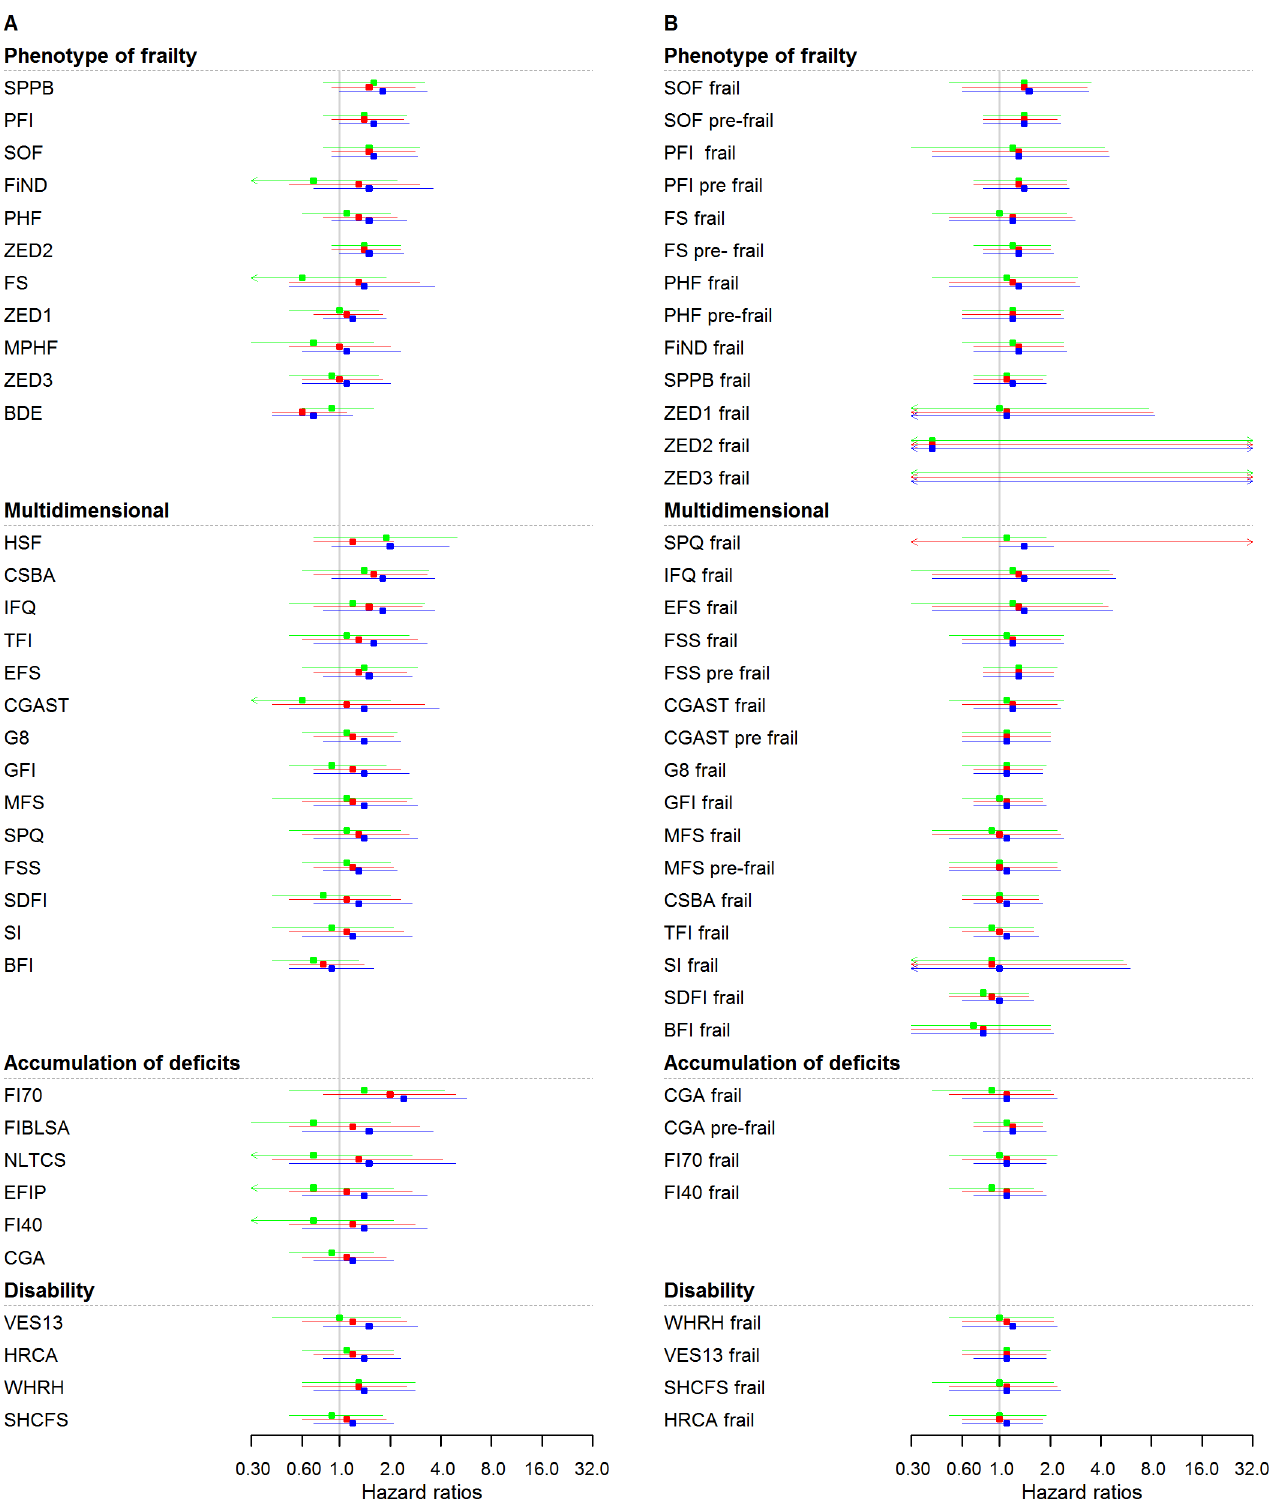
Fig 3. Cancer HRs of frailty scores ( n = 4,792): Continuous and cutoff analysis. (A) Left panel: continuous analysis; (B) right panel: categorical analysis. Models were fitted using age as timescale, with time 0 = age at entry of study and time 1 = age at event or censoring date. Model 1 in blue: adjusted by sex. Model 2 in red: Model 1 + smoking status, alcohol, and alcohol consumption. Model 3 in green: Model 2 + physical activity, BMI, diabetes, hypertension,